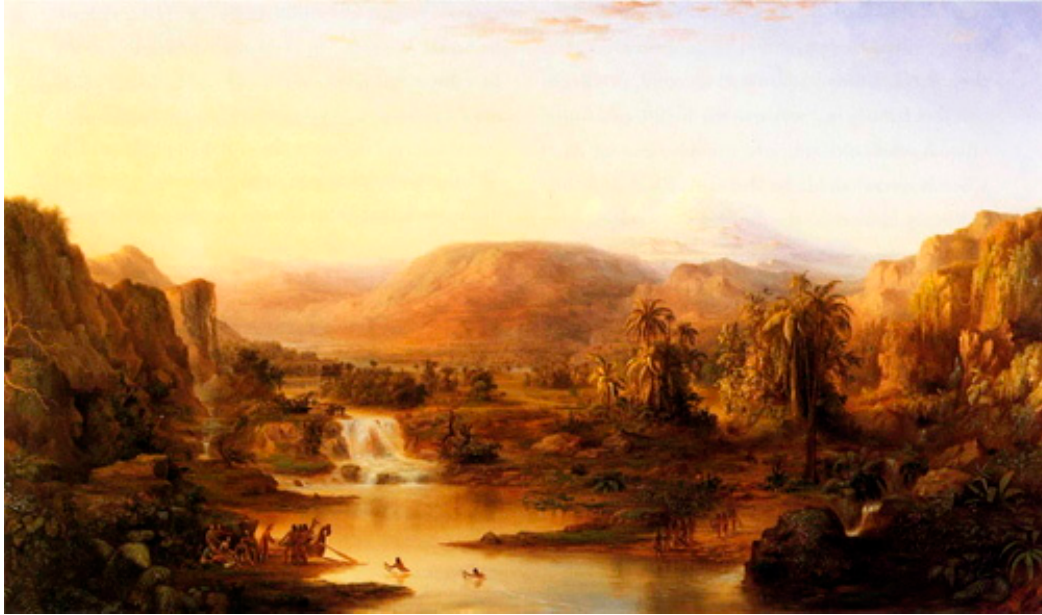
Figure 2. Land of the Lotus Eaters: Robert Duncanson, 1863.